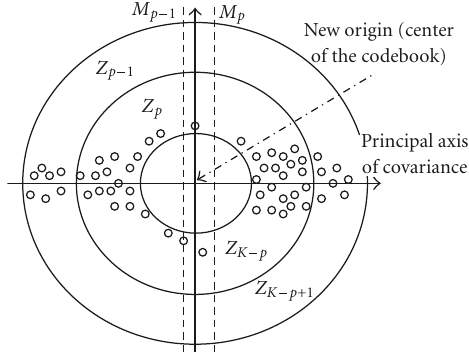
Figure 7: Iterative construction of the zones (only codevectors be- longing to zones Z p − 1 , Z p , Z K − p +1 , and Z K − p are shown).